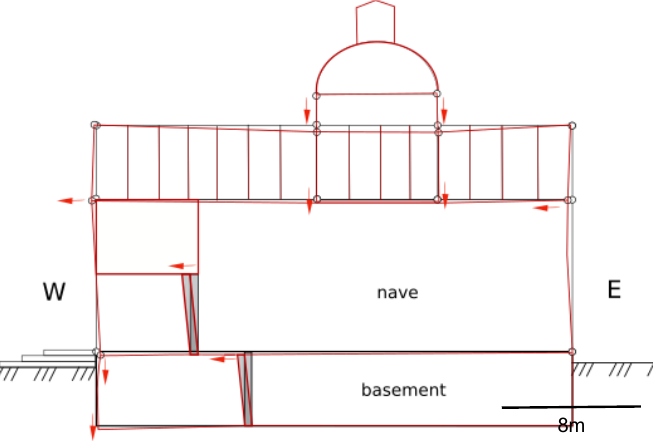
Figure 13. View of identified displacements of church structure.